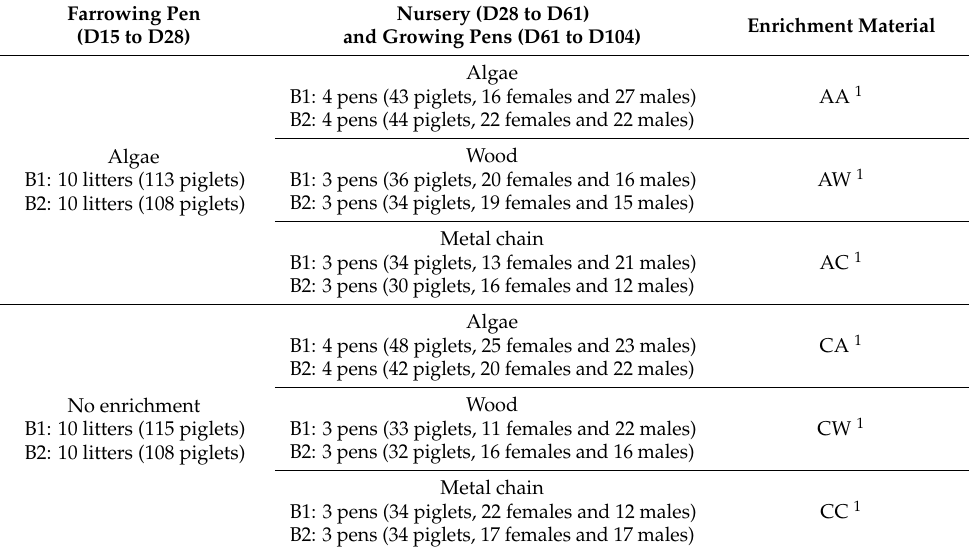
Table 1. Experimental design and types of enrichment. Pigs from one litter remained together in the same group and in the same pen during the whole study period. D: day of experiment; B: